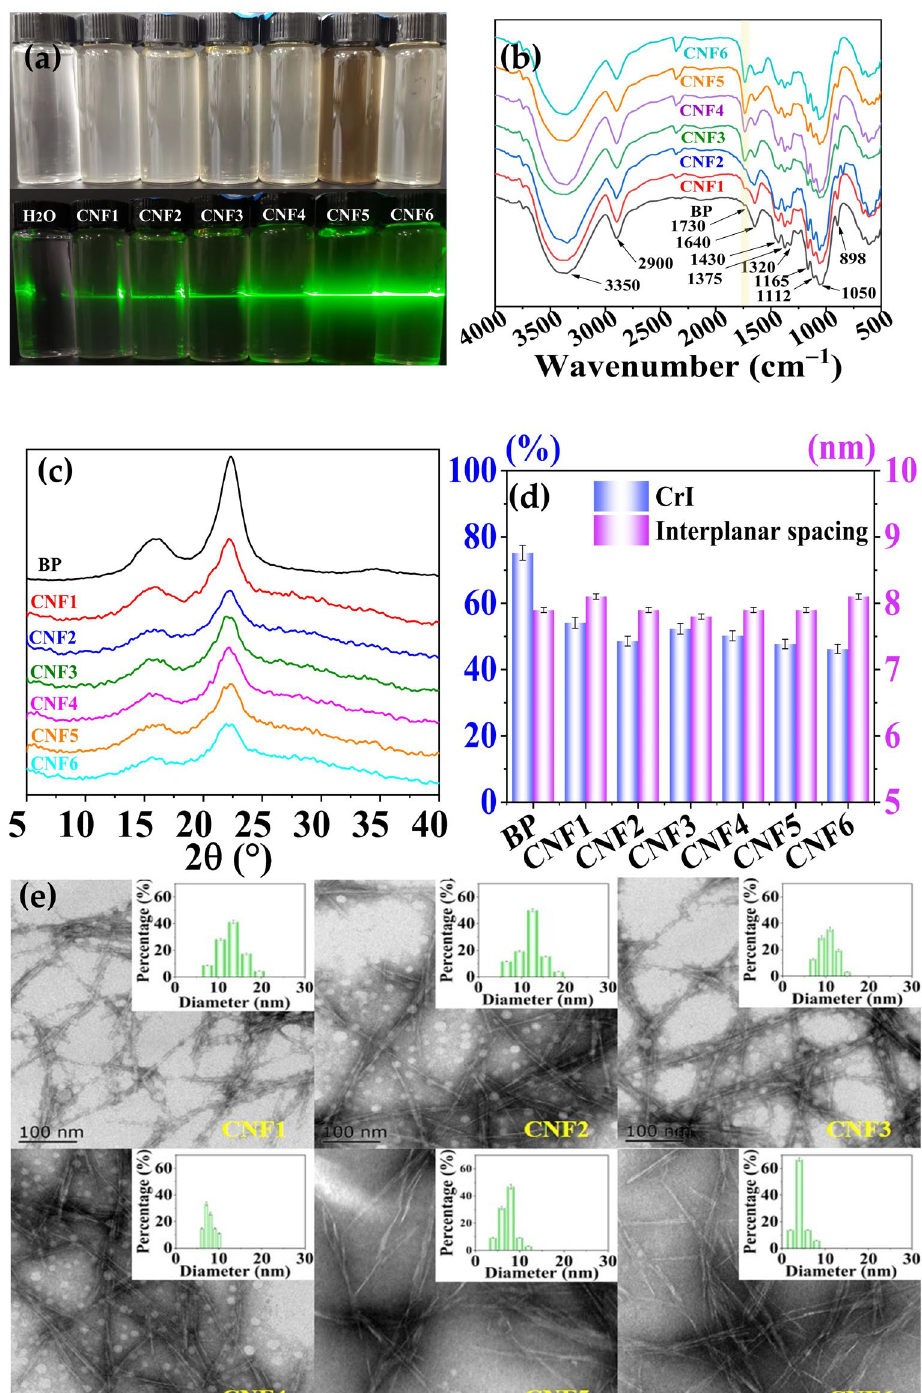
Figure 1. Structural characteristics of the CNFs. ( a ) Tyndall effect of CNFs; ( b ) FTIR spectra of BP and CNFs; ( c ) XRD diffraction of the BP and CNFs; ( d ) crystalline and interplanar spacing of the BP and CNFs; ( e ) TEM and the diameter distribution of the CNFs.